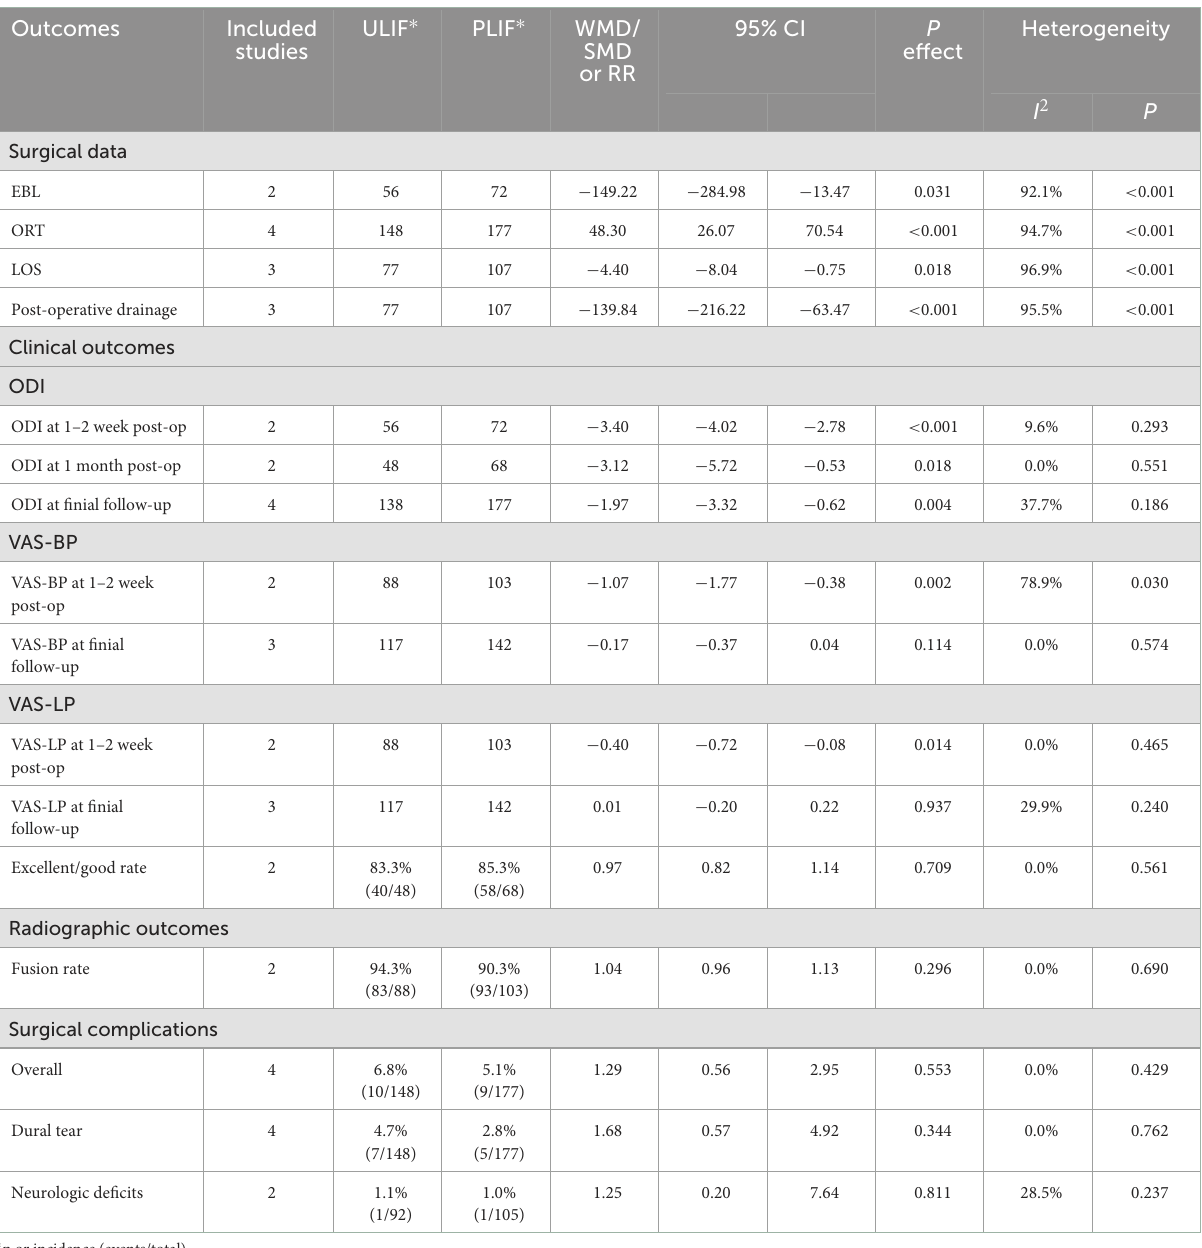
TABLE 4 The pooled outcomes between ULIF and PLIF group. Outcomes Included ULIF studies